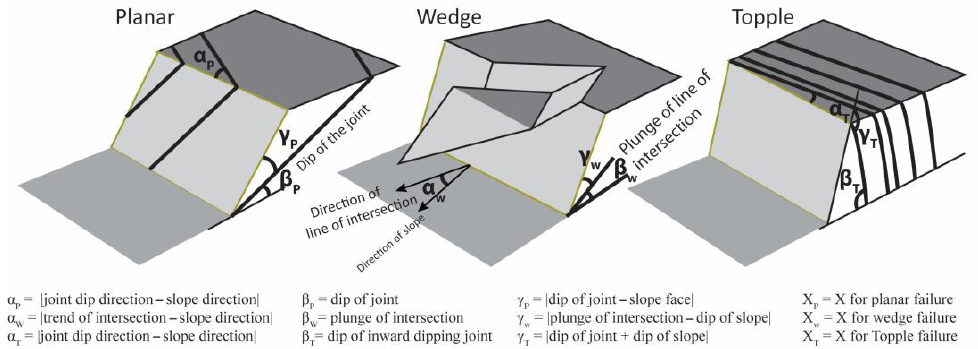
Figure 1. Description of the angular relationships between joints and slope surface for planar, wedge, and flexural topple conditions. The X stands for α, β, or γ (angular relationship determinant) described in the figure.